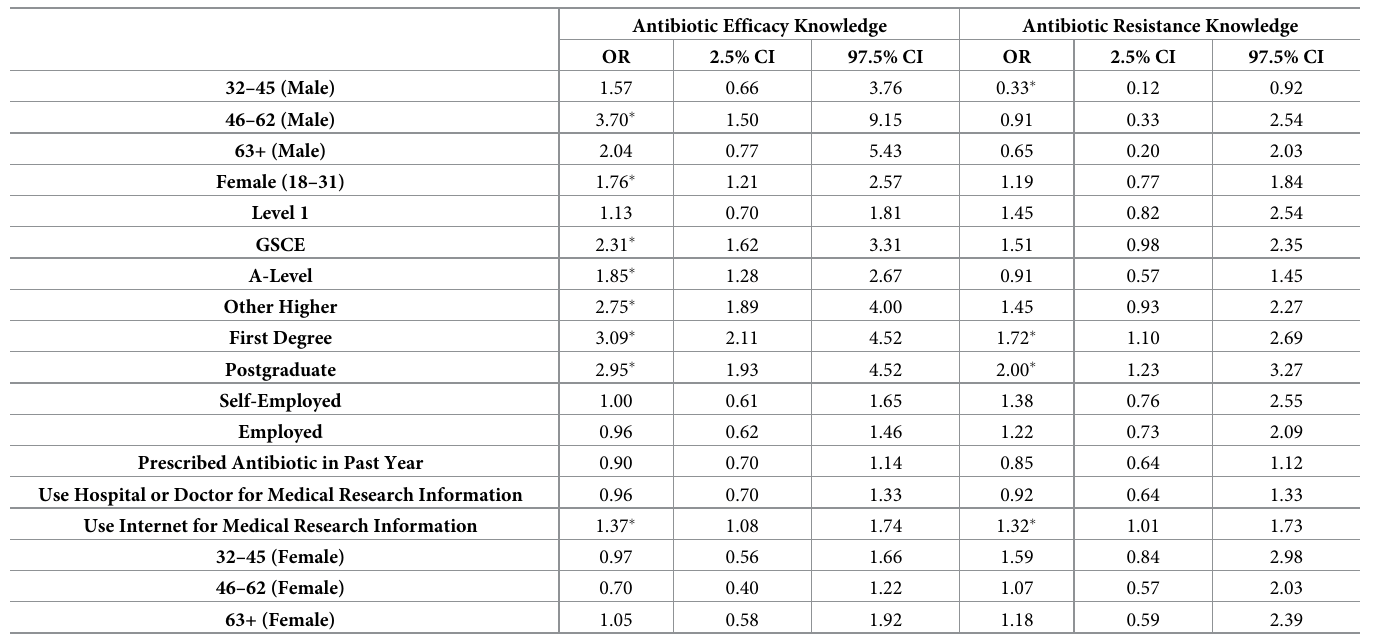
Table 3. Ordinal regression analysis of monitor knowledge